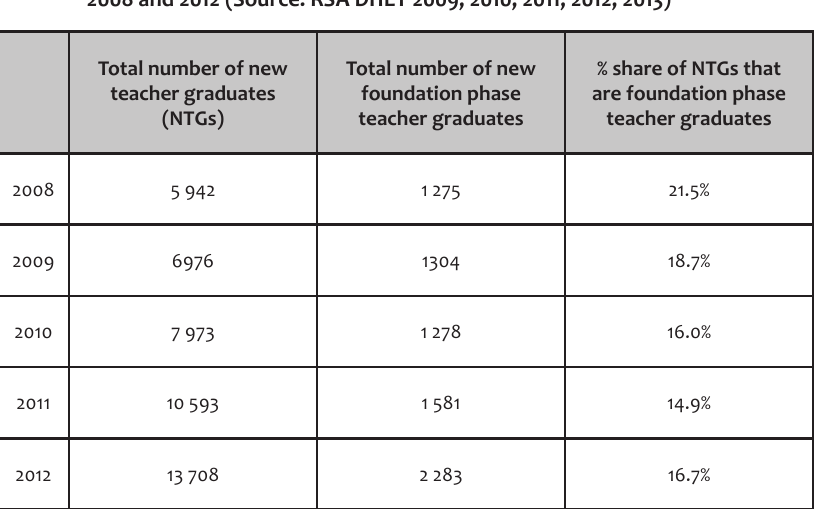
Table 1: New teacher graduates from public HEIs qualified to teach in the foundation phase as a share of the total number of new teacher graduates between 2008 and 2012 (Source: RSA DHET 2009; 2010; 2011; 2012;